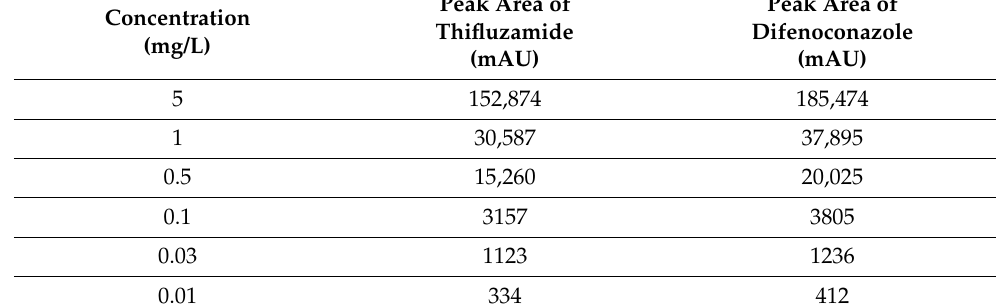
Table 5. Calibration details—thifluzamide and difenoconazole.